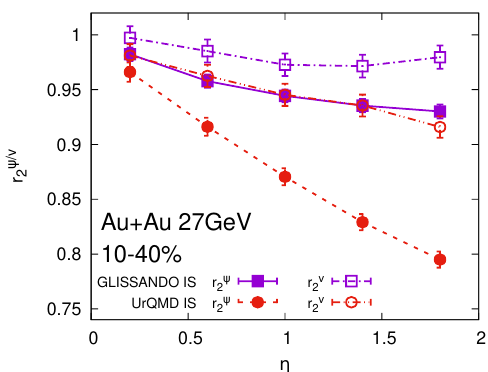
Figure 2: Pseudorapidity dependence of the decorrelation of the flow magnitude r v and the flow angle r Ψ of charged hadrons for 10 − 40% Au-Au collisions at (cid:112) s 2 27 GeV. Figure taken with permission from [ 6 ] .